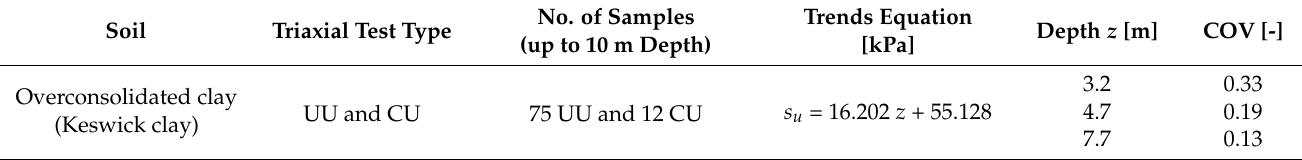
Table 2. Variability of Keswick clay according to Appendix C to